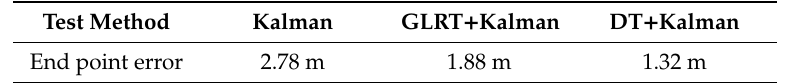
Table 5. Comparison of end point positioning errors in Indoor track 3 .